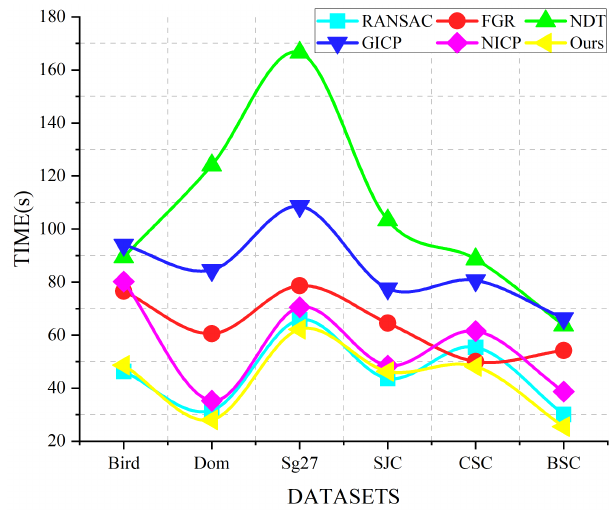
Figure 13. Registration time statistics. Time taken for different methods to process